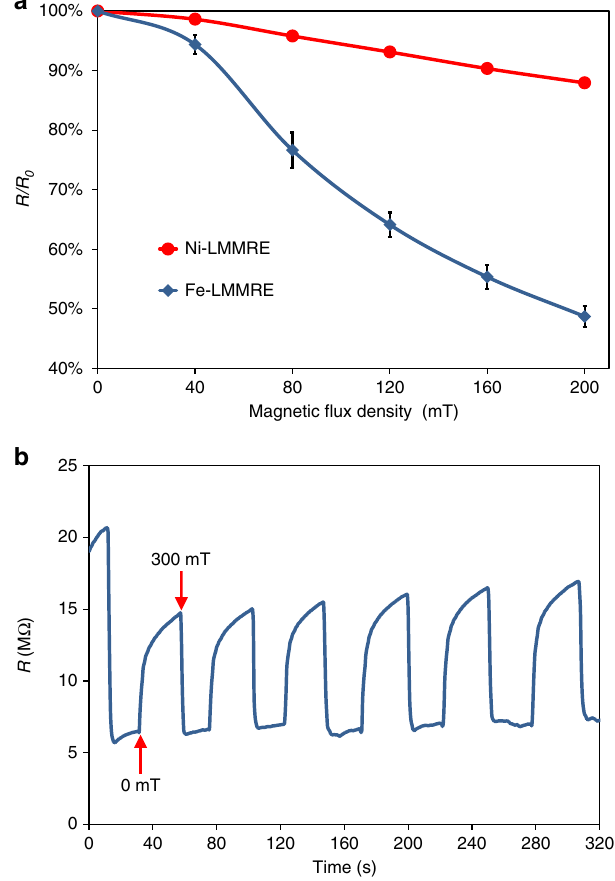
Fig. 4 Response of the liquid metal- fi lled magnetorheological elastomer (LMMRE) to magnetic fi eld. a The resistance changes of iron (Fe)- and nickel (Ni)-LMMRE (LMMRE using Fe and Ni microparticles) in the magnetic fi eld. The value of the error bar is the standard deviation of the sample resistivity under fi ve measurements. b The resistance change of Fe-LMMRE in periodic magnetic fi